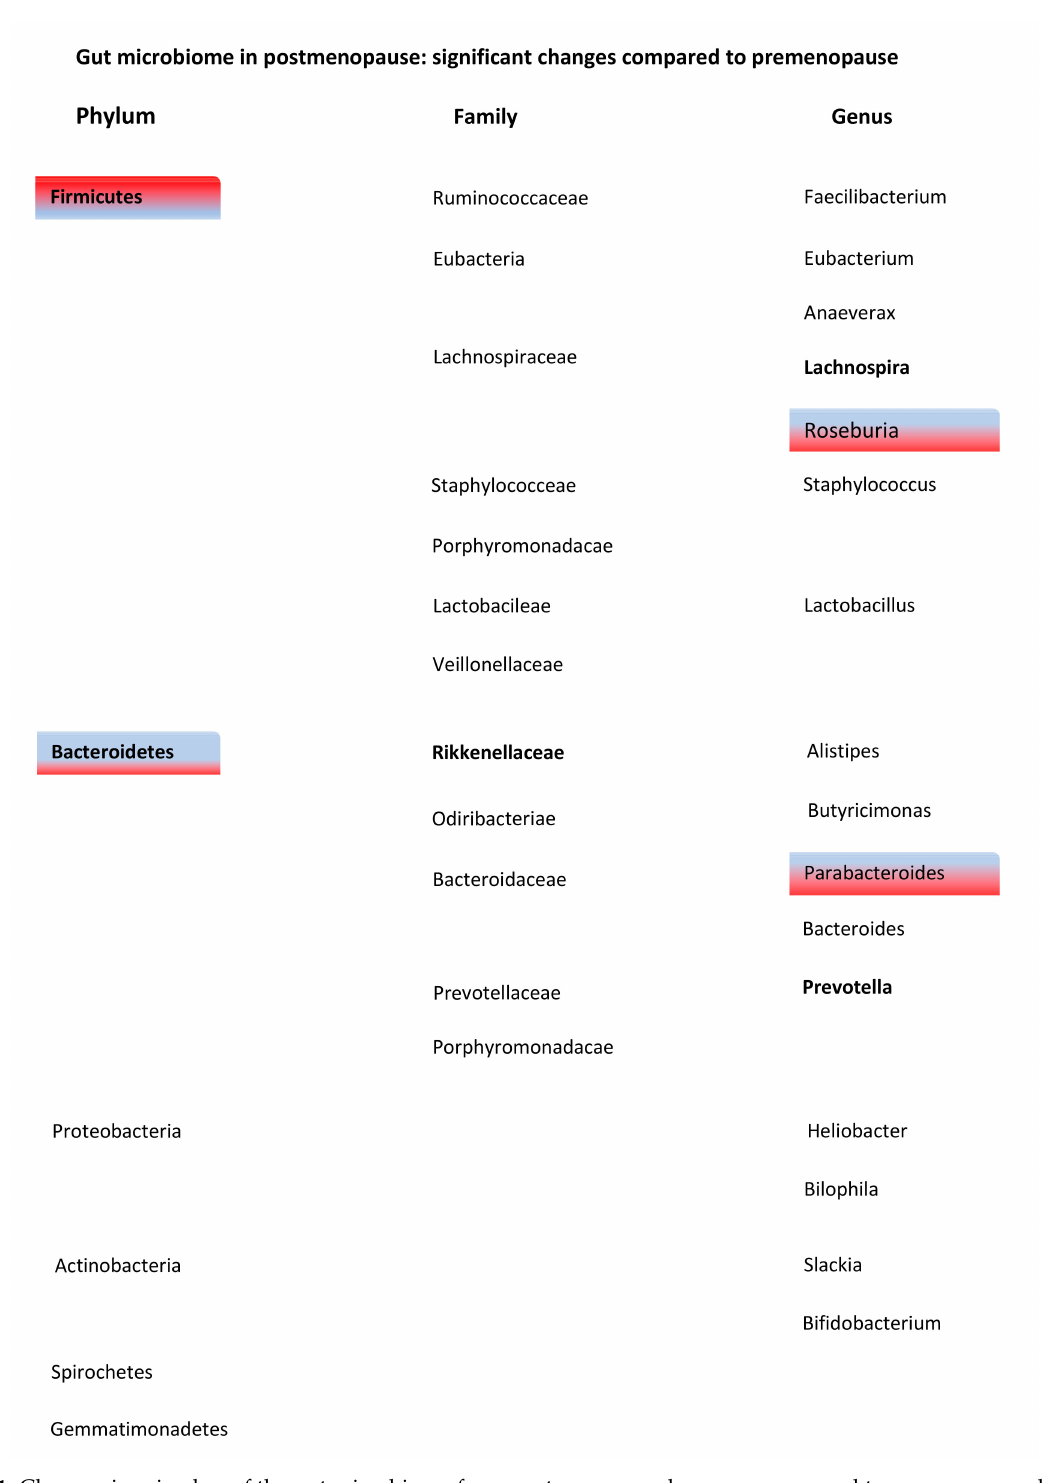
Figure 1. Changes in microbes of the gut microbiome from postmenopausal women compared to premenopausal women. Phyla are divided in families and genera. Red corresponds with an increase and blue corresponds with a decrease in relative abundance of phylum, family or genus in postmenopausal women. No color represents that this phylum or family was not specifically mentioned in the literature. When text font is bold, more than one article found this